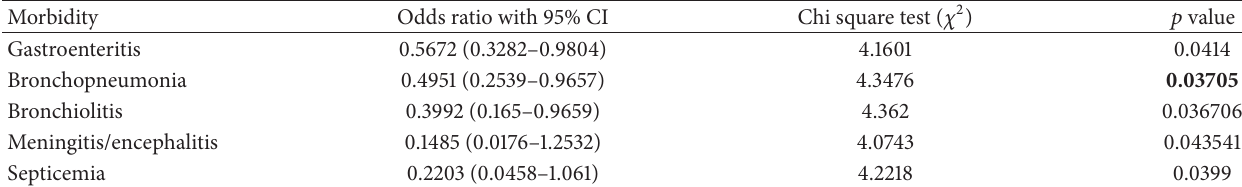
Table 5: Tests of significance depicting morbidity pattern in relation to